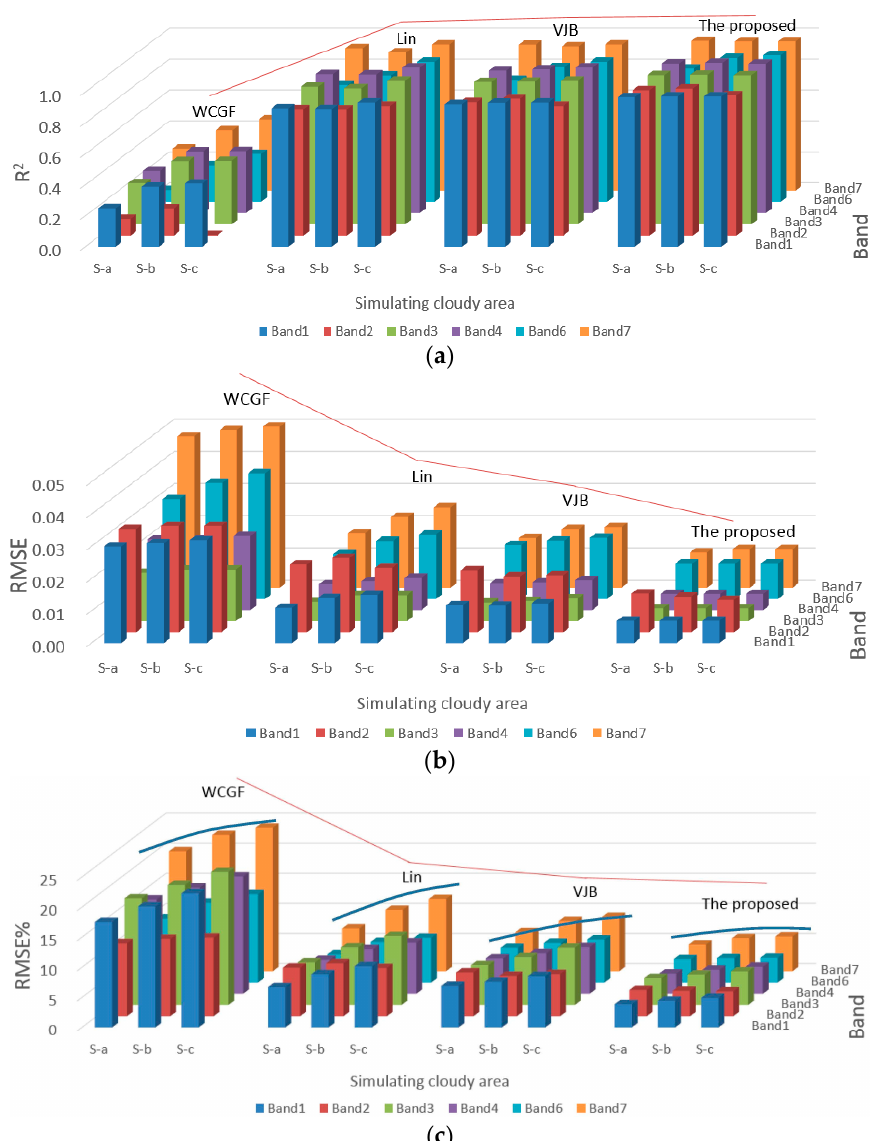
Figure 9. Column plots of the precision statistics based on Table 1: ( a ) R 2 versus modeling method for bands 1, 2, 3, 4, 6 and 7; ( b ) RMSE versus modeling method for bands 1, 2, 3, 4, 6 and 7; and ( c ) RMSE% versus modeling method for bands 1, 2, 3, 4, 6 and 7.